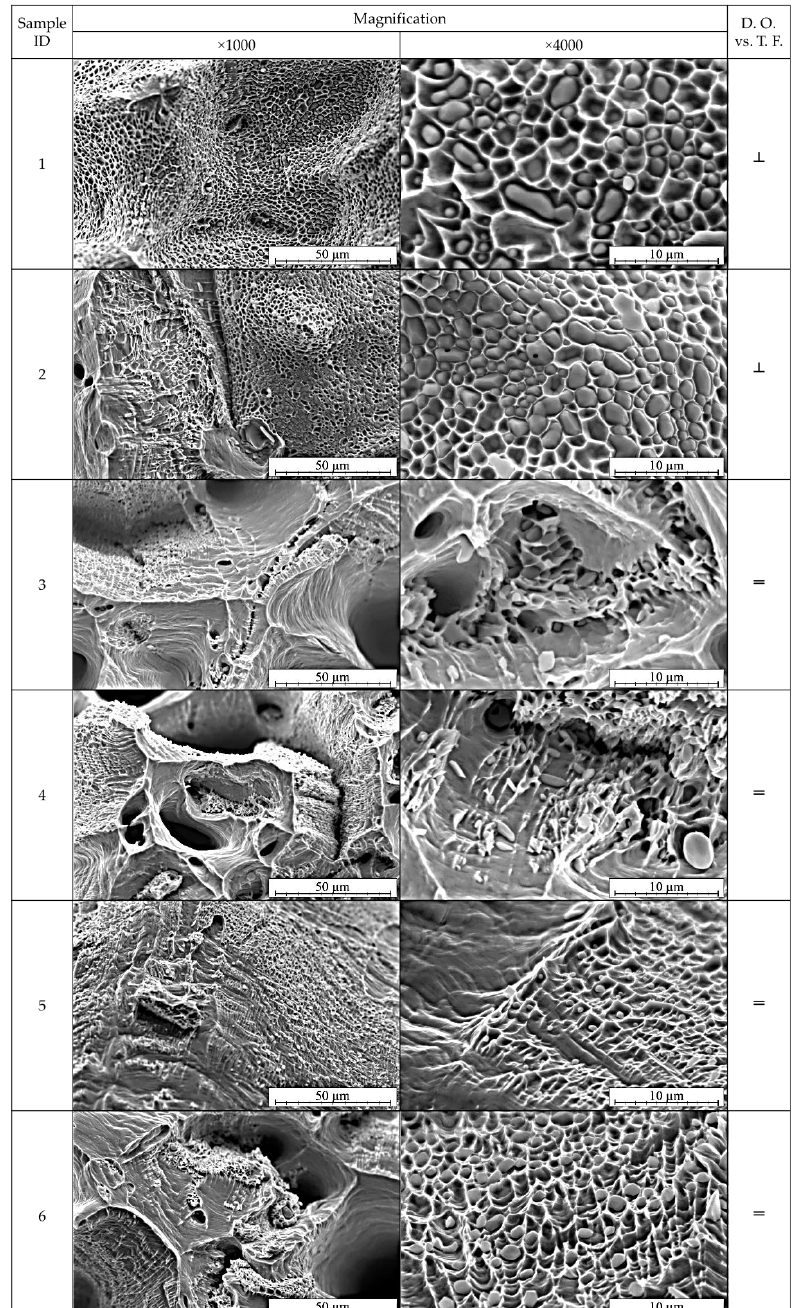
Figure 8. SEM analysis of the fractures after uniaxial tensile test of the samples prepared parallelly to the tensile force direction (see Figure 6). SEM, SE, magnification ×1000 and ×4000.